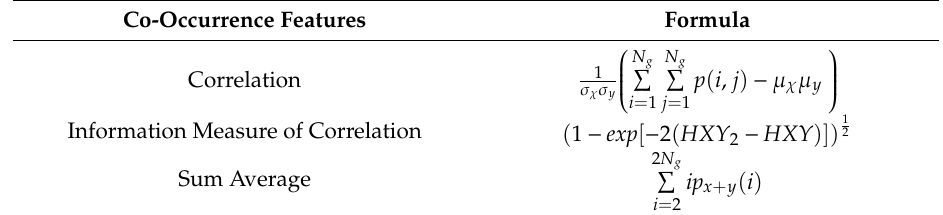
Table 1. Mathematic description of the most important identified features of Co-Occurrence approach. Co-Occurrence Features